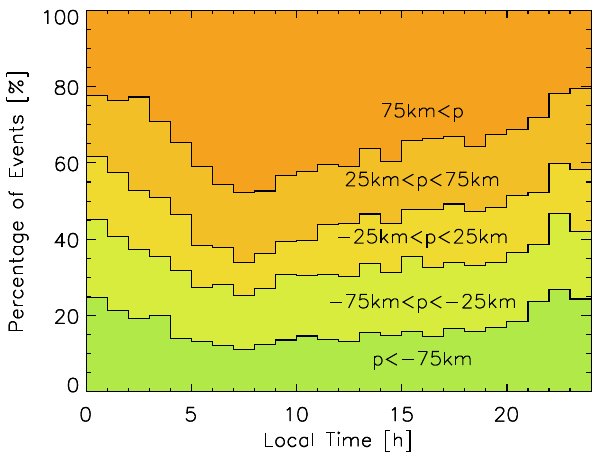
Fig. 9. Percentage of events showing a FLRD computed phase shift width p in the intervals p< − 75km (darker green), − 75km <p< − 25km (light green), − 25km <p< 25km (yellow), 25km < p < 75km (light orange) and 75km <p (darker orange) against local time. Binning of local time axis: one hour.